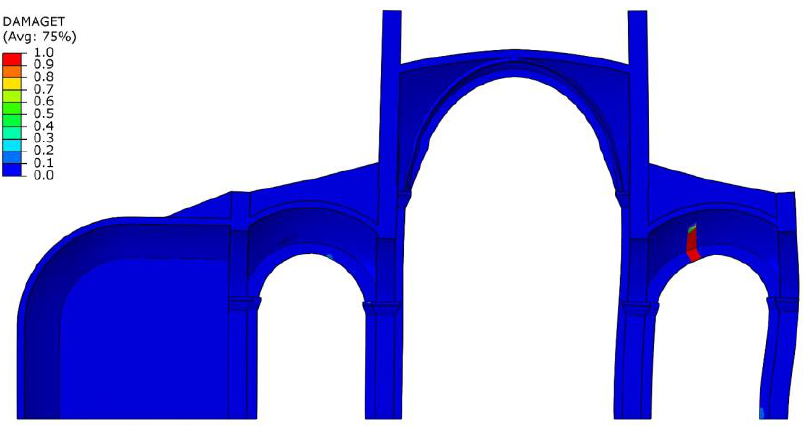
Figure 17. Damage in the southern aisle due to the removal of the chapel in the current configuration.